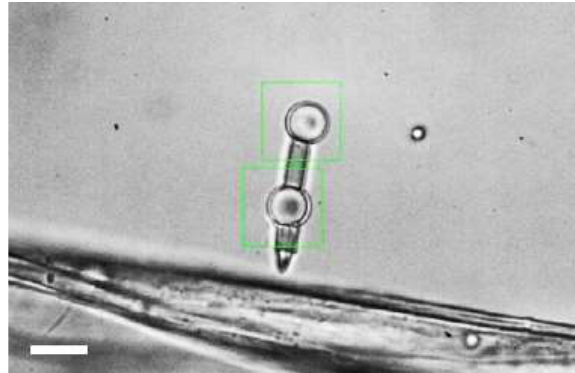
Figure 8. A micro-tool with the probing spike touching a cotton fiber. The thickness of the fiber is about 20 µm. Scale bar: 10 µm.